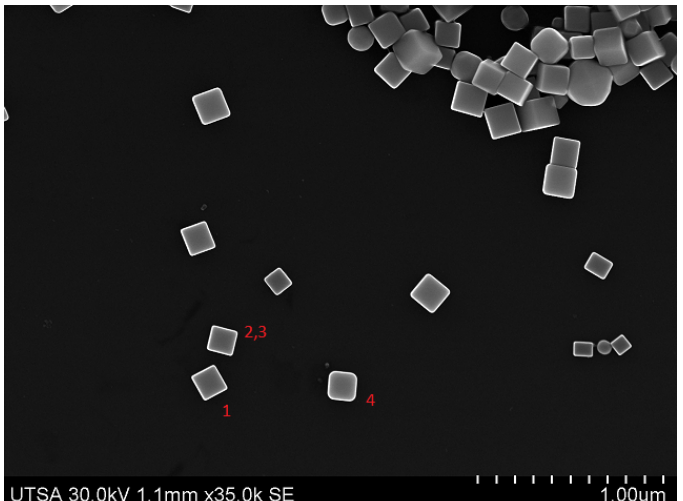
Figure 2. An example of an original SEM micrograph of Ag nanocubes from which templates were extracted.